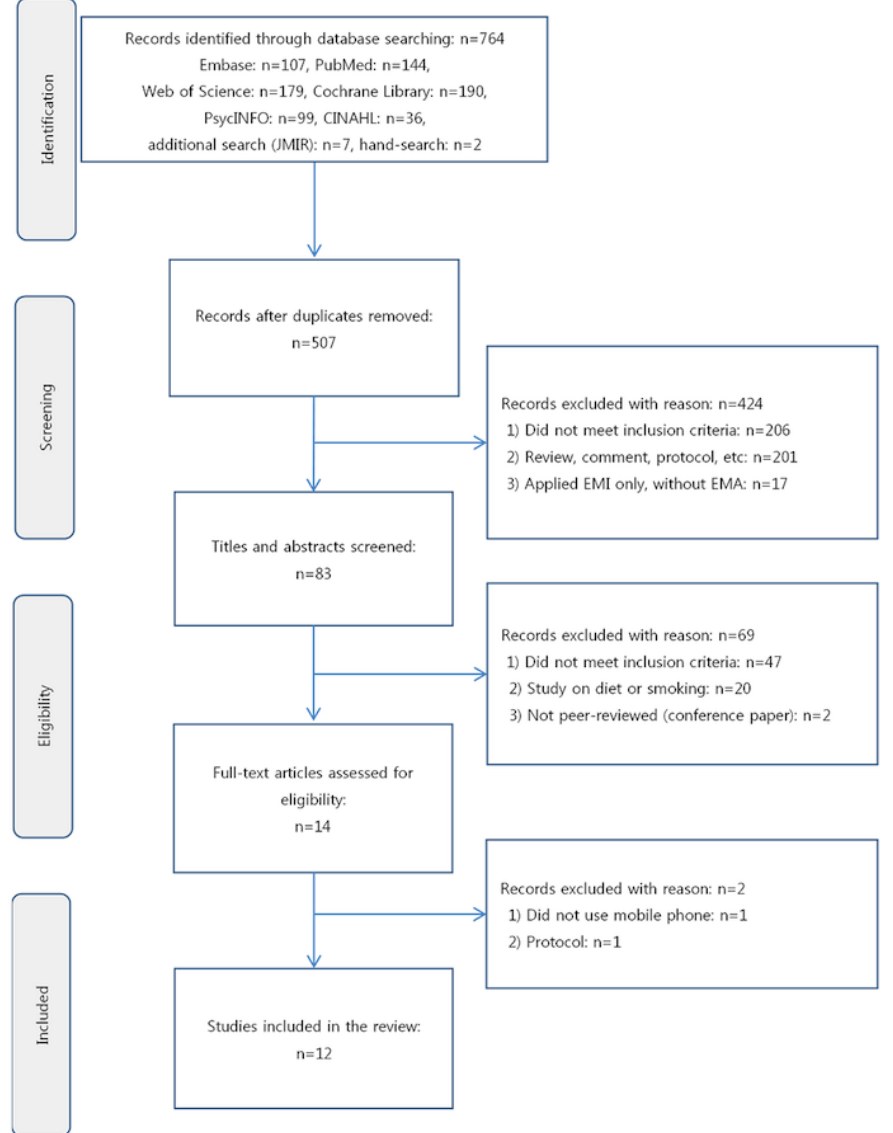
Figure 1. Preferred Reporting Items for Systematic Reviews and Meta-Analyses (PRISMA) flowchart providing an overview of the study selection process. CINAHL: Cumulative Index to Nursing and Allied Health Literature; EMA: ecological momentary assessment; EMI: ecological momentary intervention; JMIR: Journal of Medical Internet